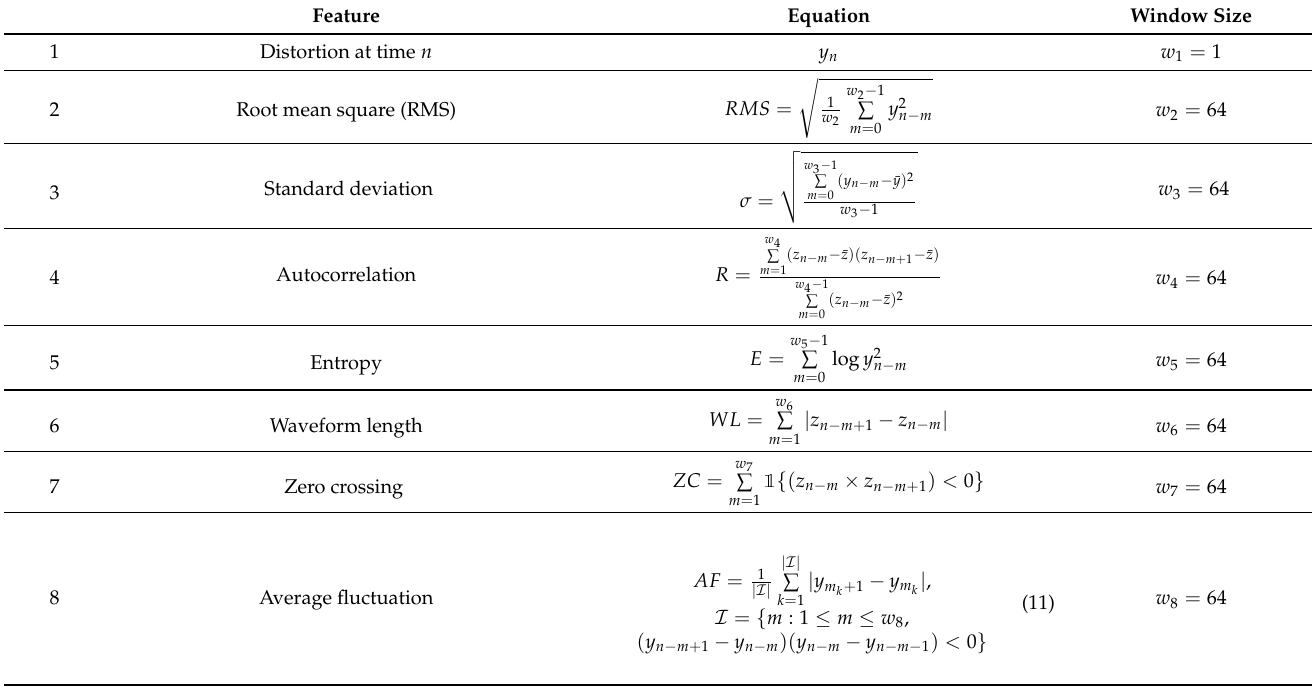
Table 1. Description of the extracted features. Features defined over y n values use the isolated distortion observations while others defined over z n values use the original voltage meter